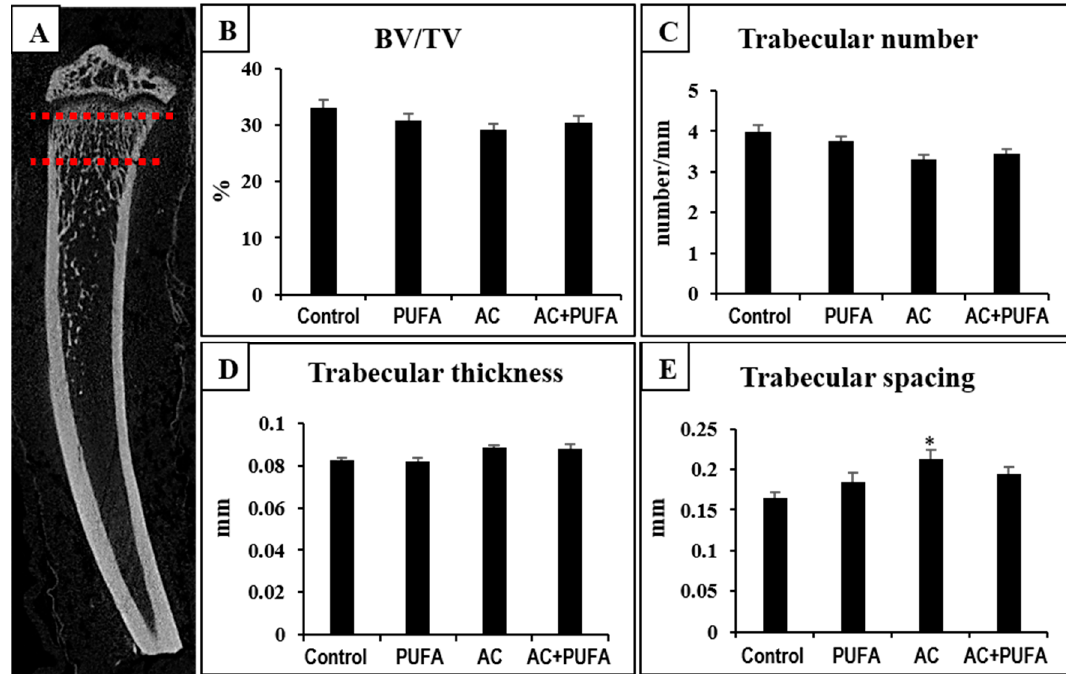
Figure 3. Effects of daily omega-3 polyunsaturated fatty acid (3PUFA) supplementation during weekly AC treatment on metaphyseal trabecular bone volume and structure. µ-CT longitudinal cross-section of a control rat tibia ( A ); Region within the red dotted line (region of interest) represents the first 2 mm of metaphysis from the end of growth plate, where all µ-CT scan data were analysed. Analyses of the treatment effects on trabecular bone volume/tissue volume (BV/TV) ( B ) and trabecular structures including trabecular number ( C ); trabecular thickness ( D ) and trabecular spacing ( E ).